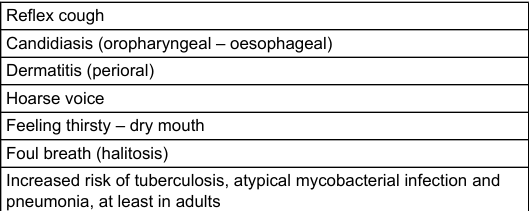
Table 1: Potential local adverse effects of inhaled